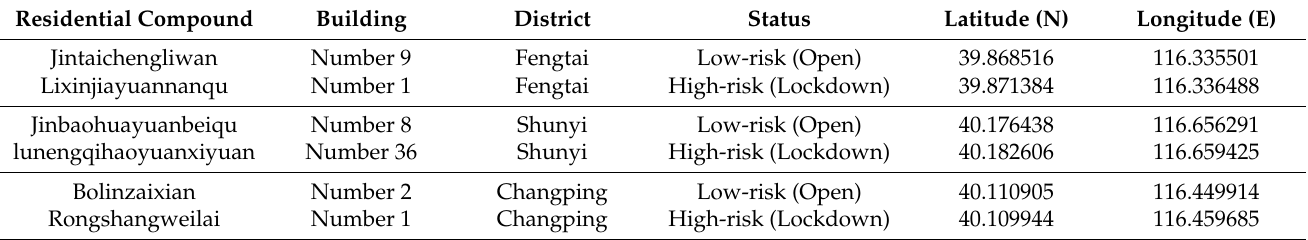
Table 3. Details of the three low-risk buildings and three high-risk